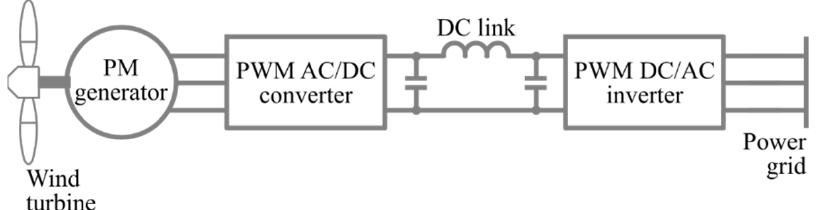
Figure 1. Direct drive generator and power electronic configuration for grid connection [35].